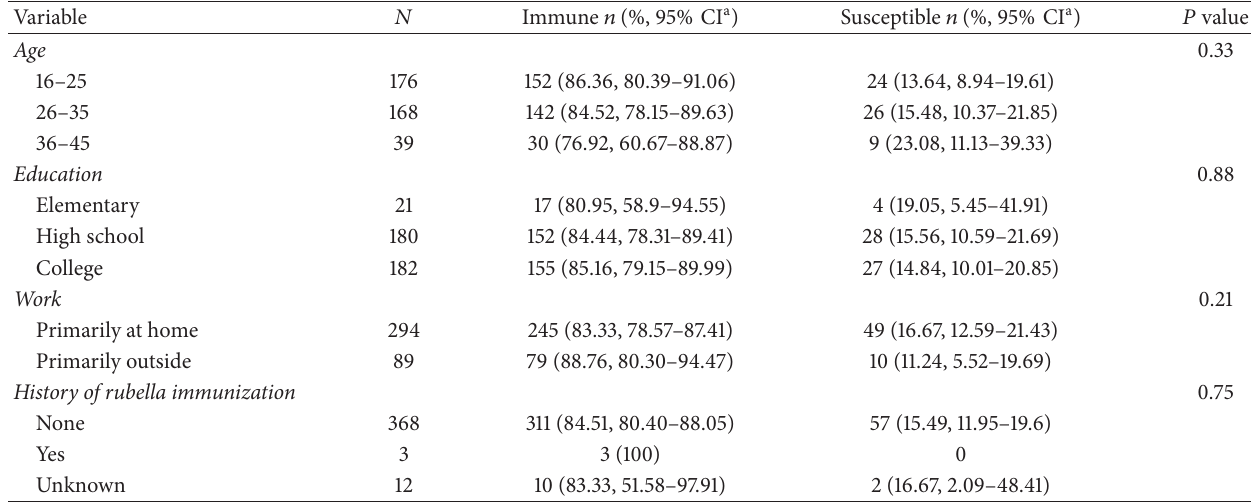
Table 3: Characteristics of pregnant women and their rubella serologic status,